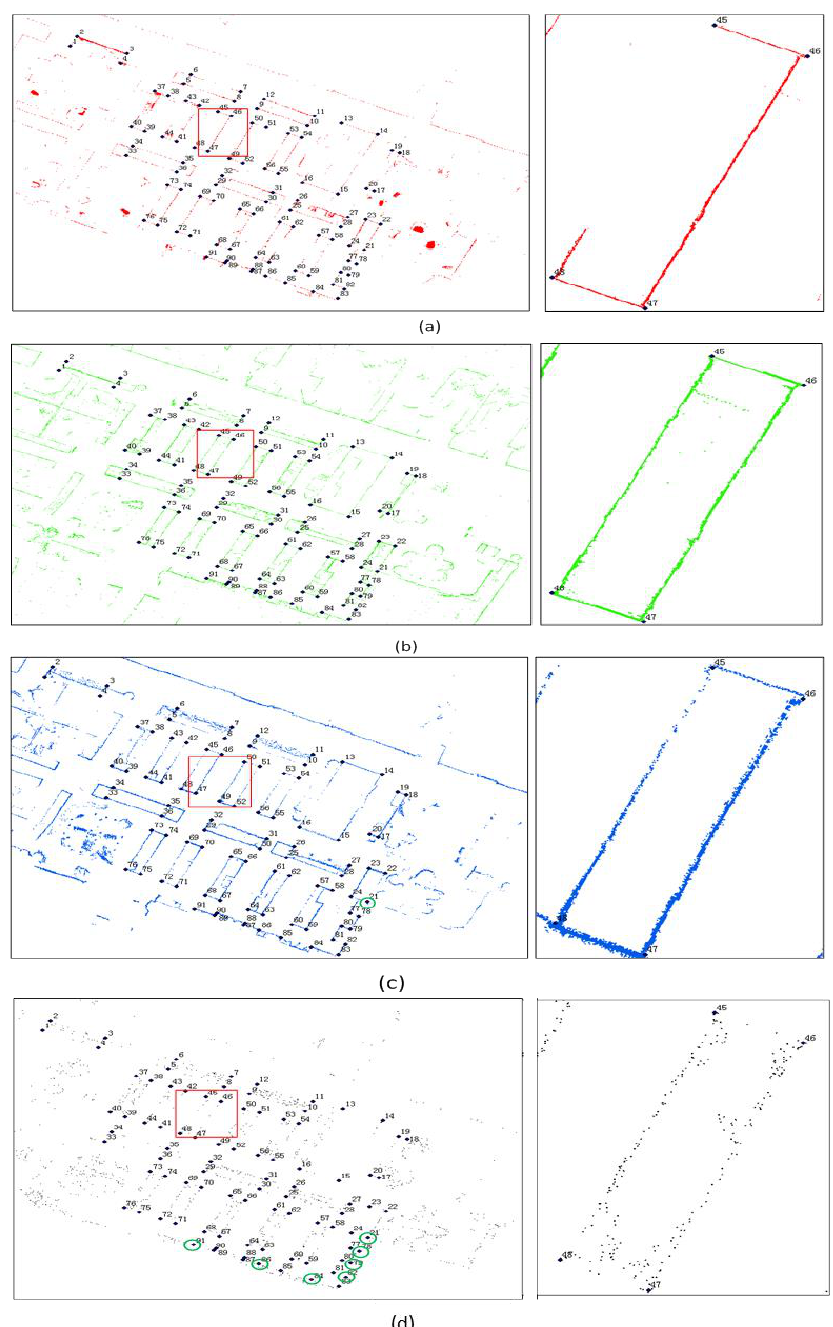
Figure 10. ( a ) TLS reference map and the interactively selected key points; ( b ) transformed SLAMMER map result with interactively selected key points by LSF algorithm ( c ) transformed NAVIS map result